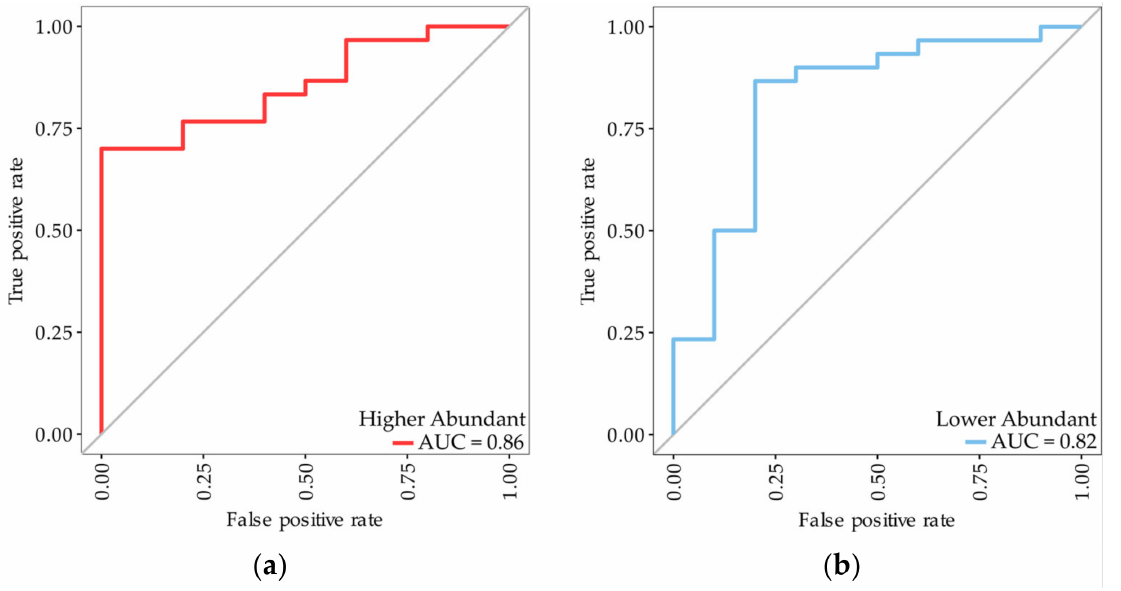
Figure 3. ROC analysis of Random Forest classifiers trained on either the ( a ) higher abundant or ( b ) lower abundant proteins from Table 4, for classification of MPM subtypes. The epithelioid subtype was selected as positive for the calculation of sensitivity and